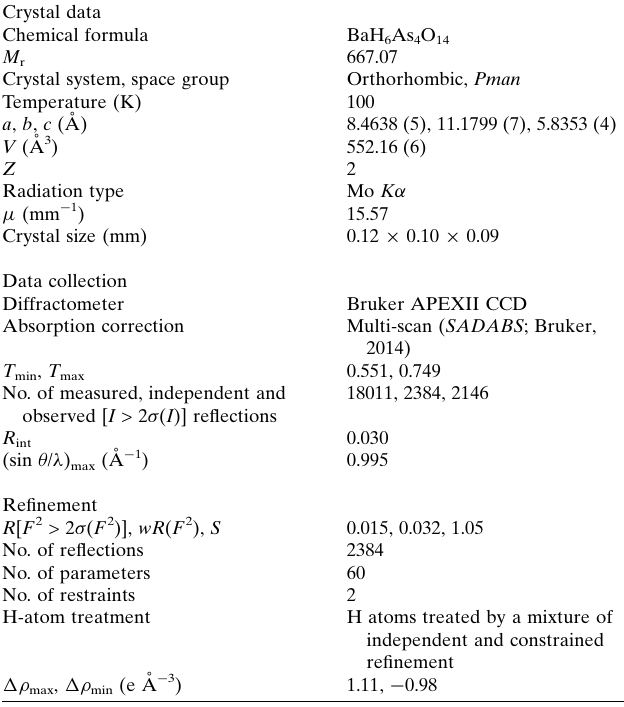
Table 3 Experimental details.